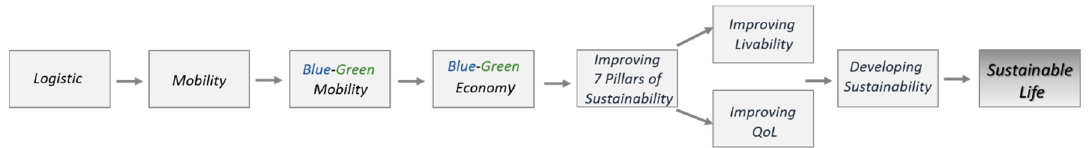
Figure 5. Blue-Green Mobility Technologies.